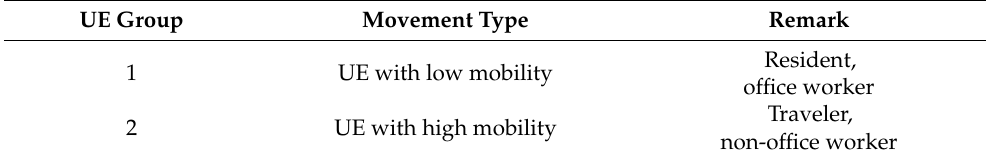
Table 3. UE group